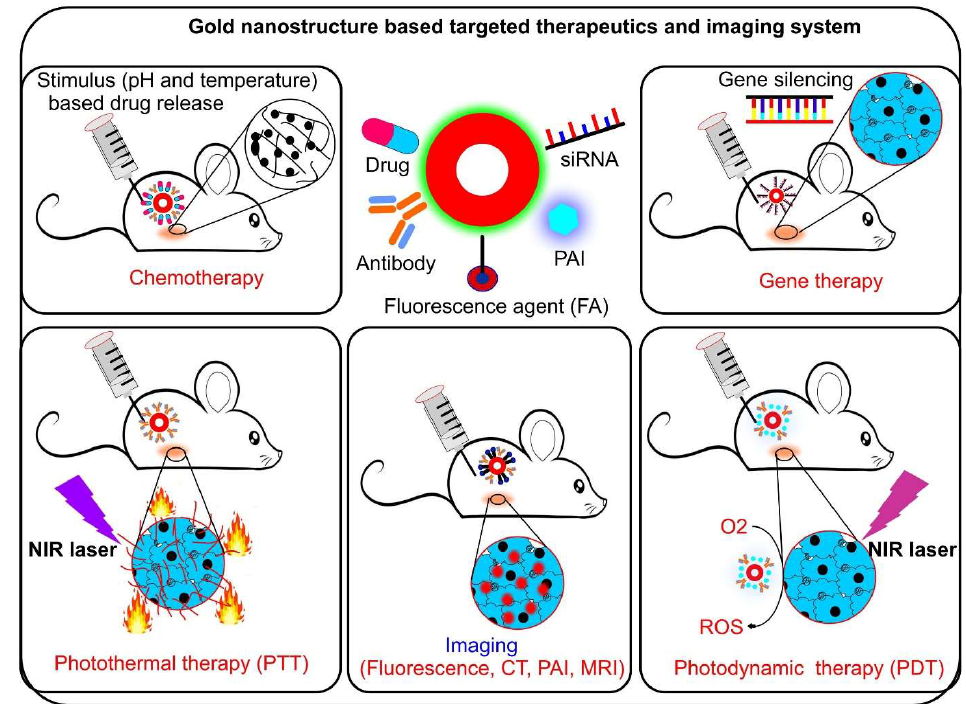
Figure 2. Diagram showing different functional entities; drug, antibody, siRNA and fluorescent agent capped around the gold nanostructure for cancer theranostic applications. The conjugation enhanced target selectivity and specificity for cancer therapies such as chemotherapy, gene therapy, photodynamic therapy, photothermal therapy, and imaging.